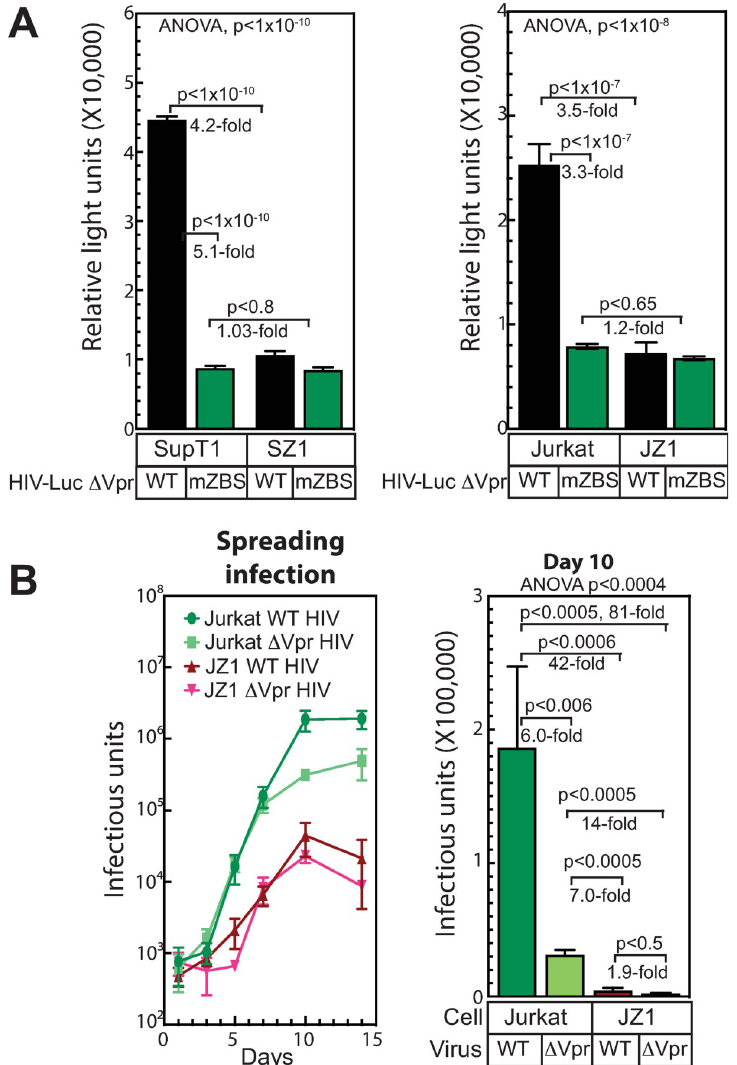
Fig 4. ZASC1 deletion reduces HIV-1 gene expression and viral replication. (A) WT or Δ ZASC1 Jurkat and SupT1 cells were challenged with equivalent amounts (based on p24 levels) of either VSV-G pseudotyped HIV-1 vector with nonsense mutations in envelope and Vpr, luciferase in the NEF locus, and either a WT LTR or an LTR with all 4 ZASC1 binding sites mutated (mZBS) [38]. (B) Replication of WT HIV-1 or HIV-1 with a Vpr nonsense mutation ( Δ Vpr) in WT or Δ ZASC1 Jurkat cells. Cells (1X10 6 ) were infected with the indicated virus at an moi of 0.005. Supernatant was titered in quadruplicate on TZMBL reporter cells at the indicated time points and infectious units counted by X-gal staining. The data shown are the average mean values obtained in an experiment performed with quadruplicate samples and are representative of three independent experiments. The bar graph is a focus on the day 10 time point. Error bars indicate the standard deviation of the data in all panels. ANOVA analysis was performed and for P-values < 0.05 a Tukey’s HSD was performed and relevant P-values reported. that while Vpr may counteract ZBTB2, completely lacking ZBTB2 may be more efficient for HIV-1 gene expression. In striking contrast, when challenged with an HIV-1 vector that was deleted for Vpr, SupT1 Δ ZBTB2 cells exhibited an 11-fold increase, and Jurkat Δ ZBTB2 cells a 4.8-fold increase in HIV-1 gene expression (Fig 5A blue bars). Given that deletion of Vpr reduced HIV-1 reporter expression in the WT SupT1 and Jurkat cells (3.1 and 3.8-fold, respectively), deletion of ZBTB2 restored the gene expression of the Δ Vpr virus to near WT